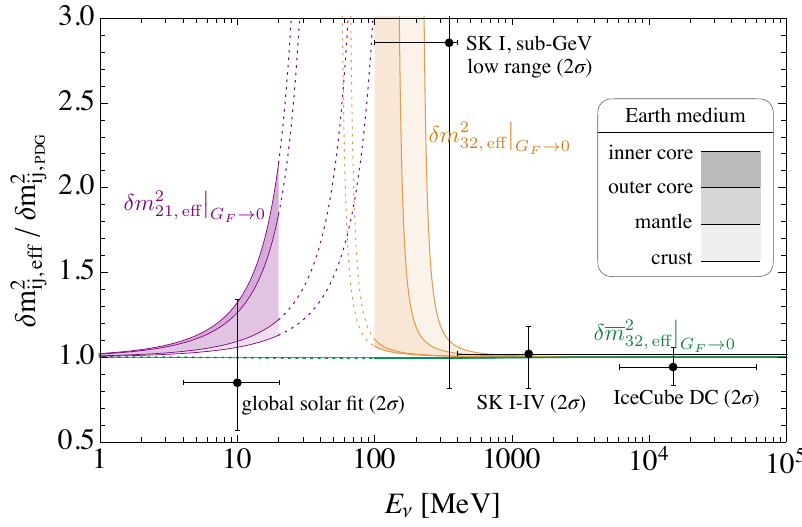
Figure 10 . Similar to figure 9, but for atmospheric (anti-)neutrinos and solar neutrinos propagating through different media within the Earth, and ignoring the SM matter effects (i.e., setting G The left-most data point corresponds to the global fit to solar neutrino data, including day- night asymmetries, obtained in [127]. The other data points correspond to atmospheric neutrino measurements from Super-Kamiokande [128, 129] and IceCube DeepCore